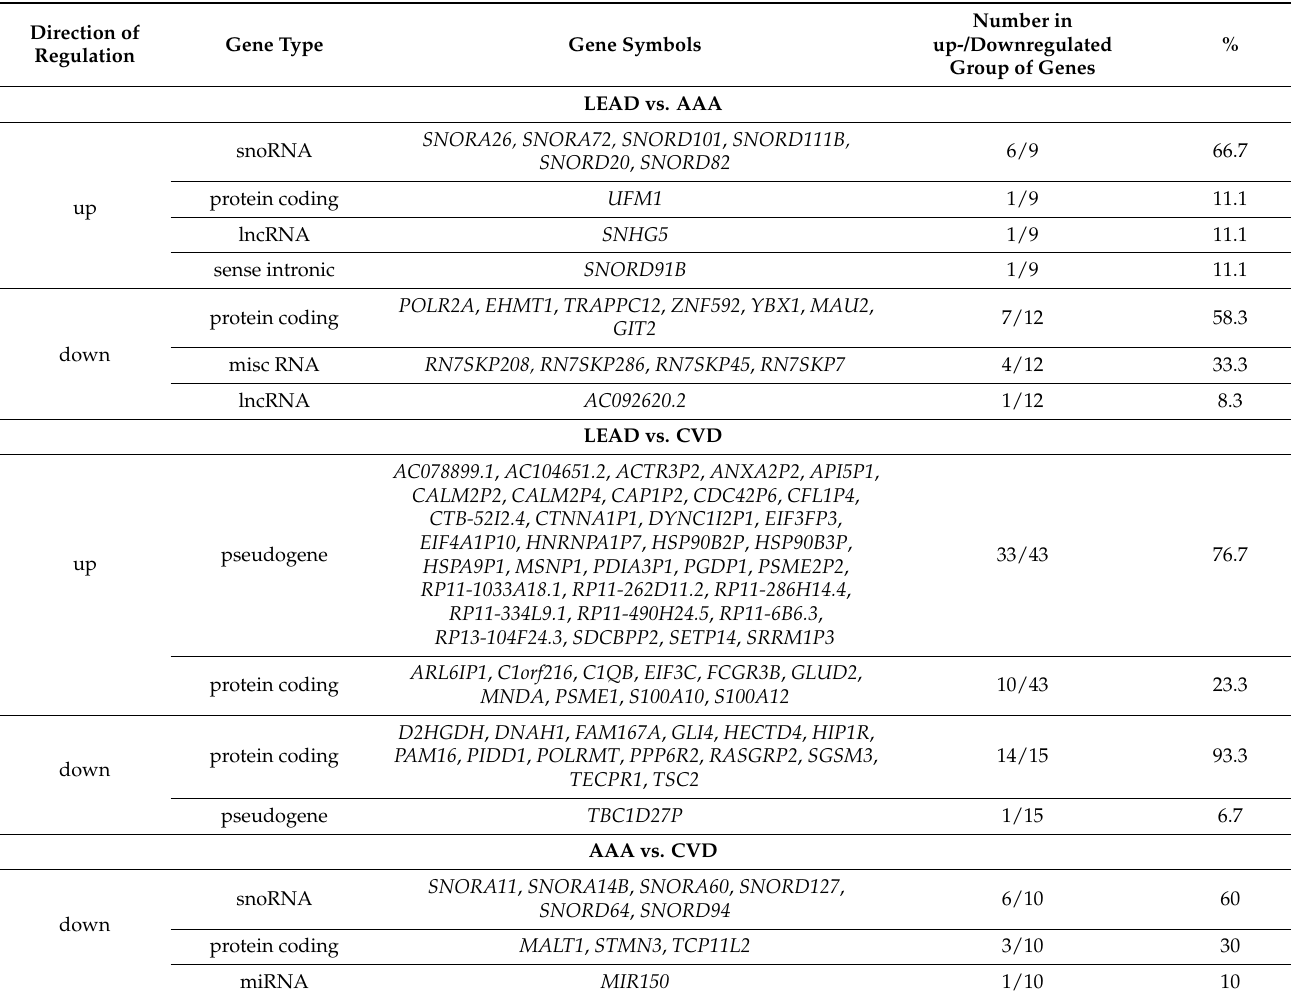
Table 5. Gene types of 21, 58 and 10 genes identified as specific for LEAD vs. AAA, LEAD vs. CVD and AAA vs. CVD comparisons, respectively. Gene types were harvested from Ensembl genome browser release 102 (http://www.ensembl. org/index.html, accessed on 20 January